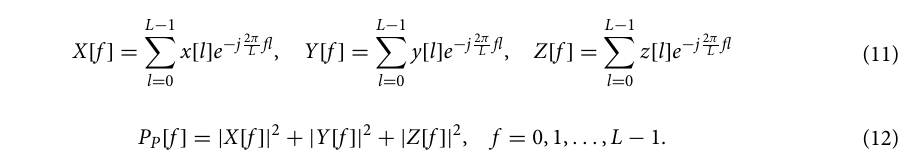
EIIP representation. EIIP values of nucleotides for representing DNA sequences and for locating exons were proposed in 46 . According to this study, the EIIP representation is 0.0806 for G, 0.1260 for A, 0.1335 for T,